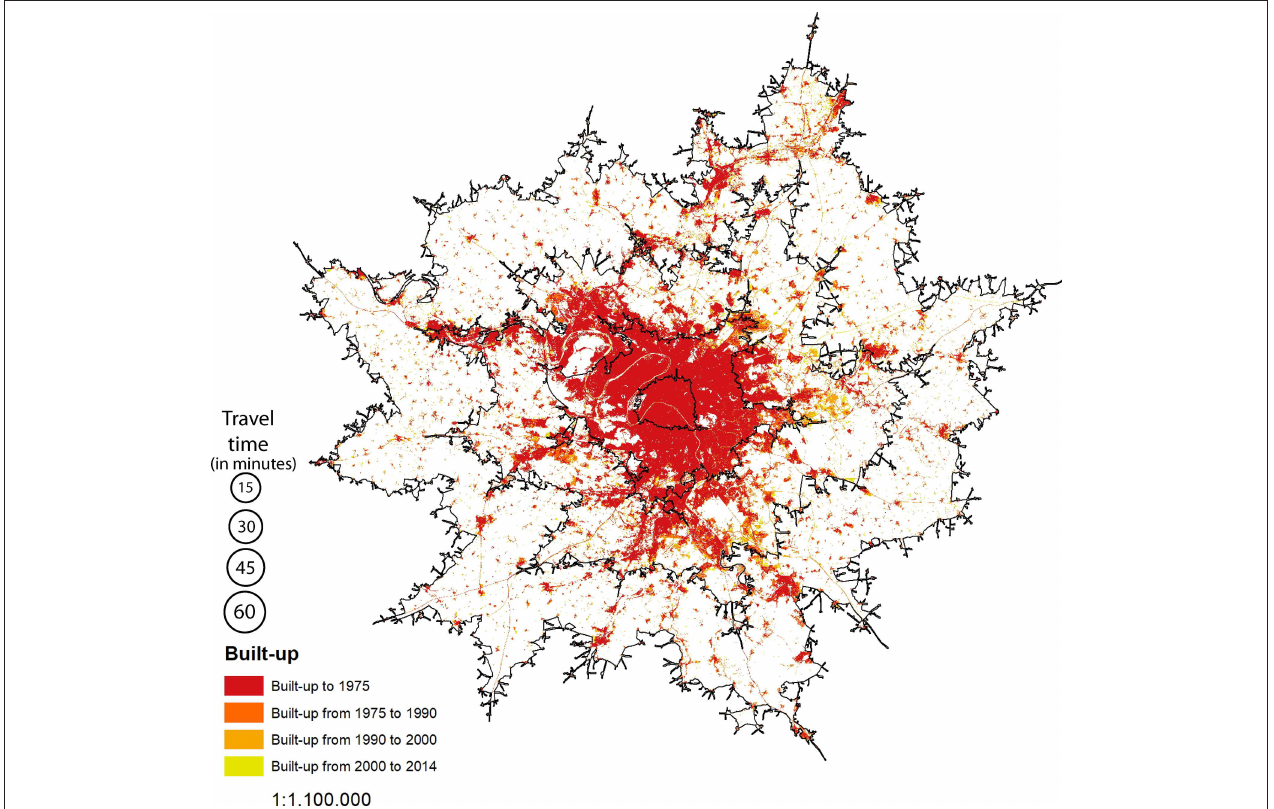
FIGURE 8 | Urbanization periods in Paris, based on the